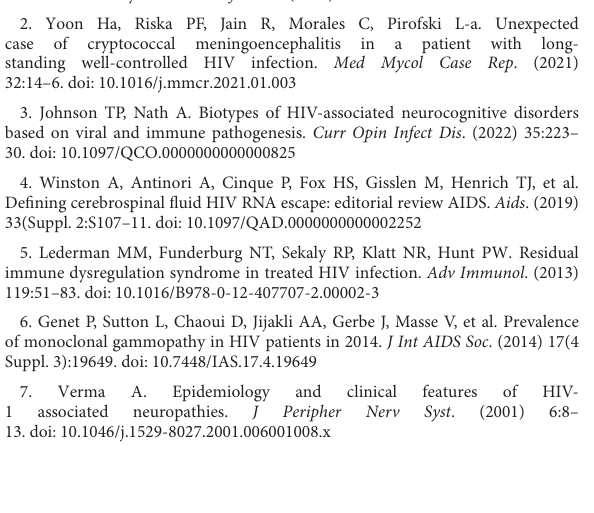
SUPPLEMENTARYFIGURE1 Identification and validation of anti-AnkG antibodies in case 2 CSF by TBIF and CBA. (A) TBIF of murine cortex with CSF from case 2 shows AIS-like structures in the cortex (arrow), hippocampus, and the cerebellum (ml, molecular layer; gl, granule cell layer) and NoR-like structures in the midbrain. (B) 270 kDa rat AnkG-mCherry CBA. HEK 293T cells were transfected with AnkG-mCherry, fixed, permeabilized, and stained with CSF at a 1:100 dilution and DAPI. Scale bar = 10 µ